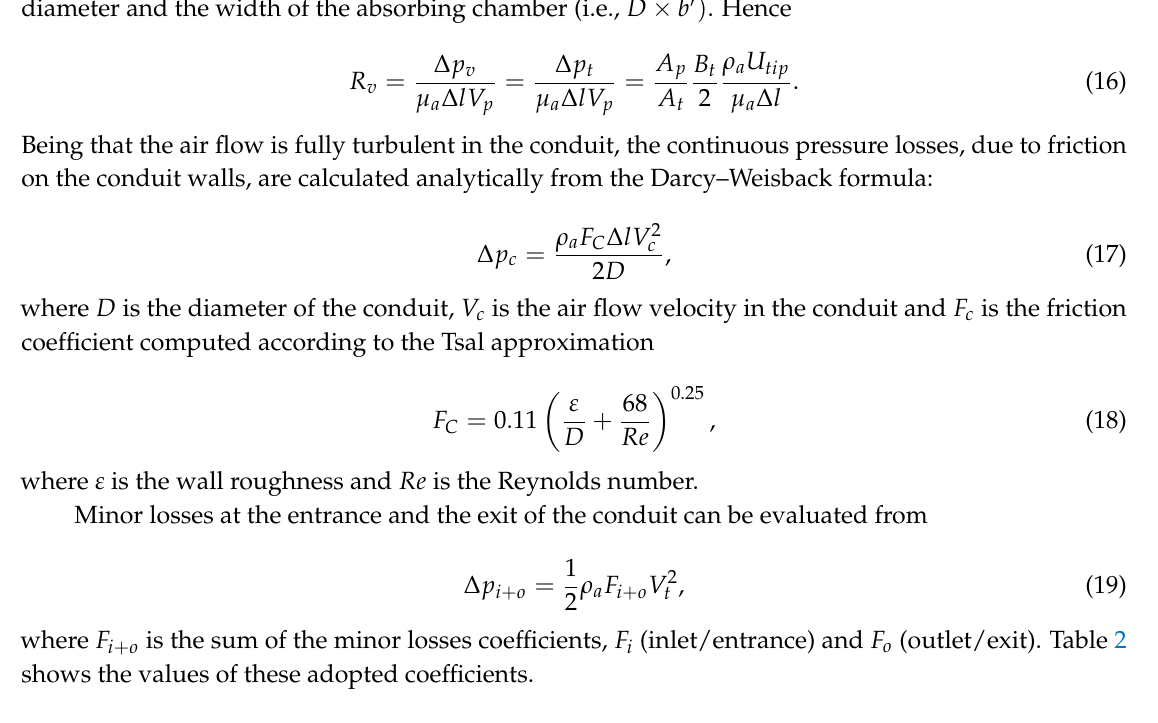
Table 2. Parameters assumed for the computation of the continuous and minor